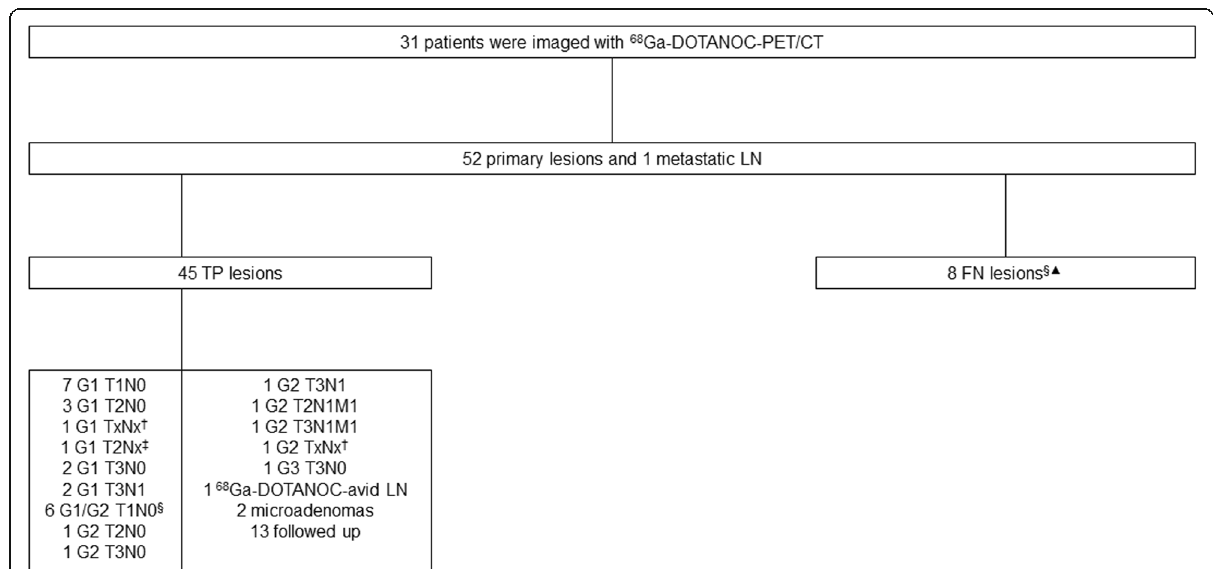
Fig. 1 Characteristics of lesions detected on 68 Ga-DOTANOC-PET/CT. TP, true-positive; FP, false-positive; TN, true-negative; FN, false negative; LN, lymph node. † Diagnosis was made by biopsy, stage unknown. ‡ Unknown lymph node status due to enucleation. § MEN1 patient, who underwent total